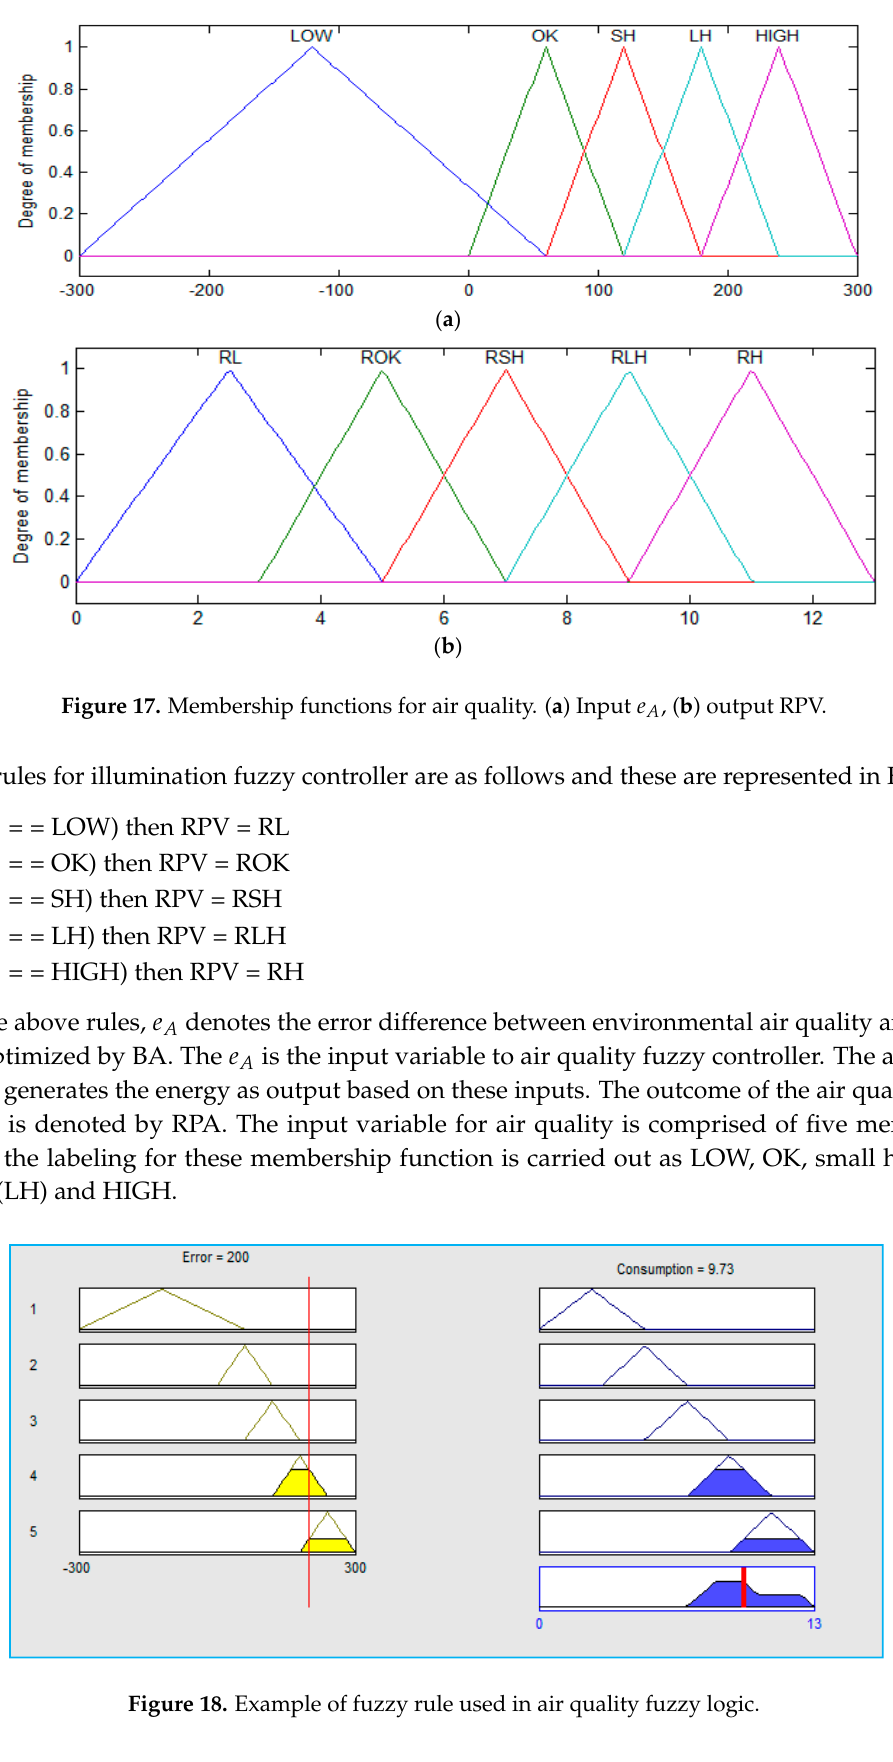
Figure 18. Example of fuzzy rule used in air quality fuzzy logic.